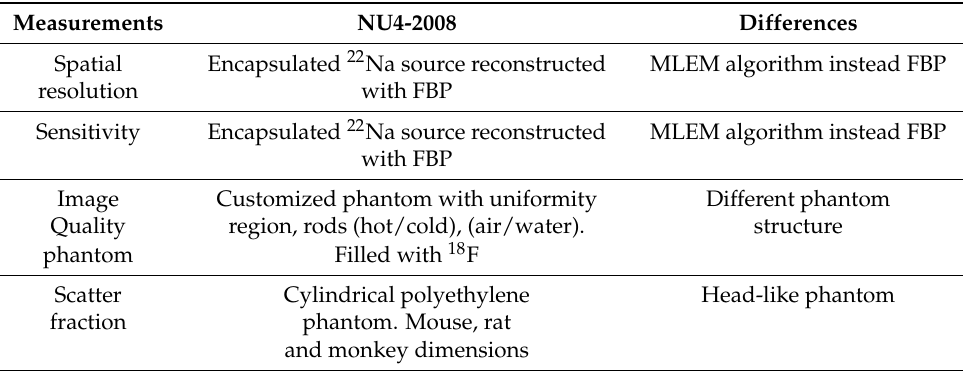
Table 4. NEMA NU4-2008 measurements performed and the main differences adopted for this study.